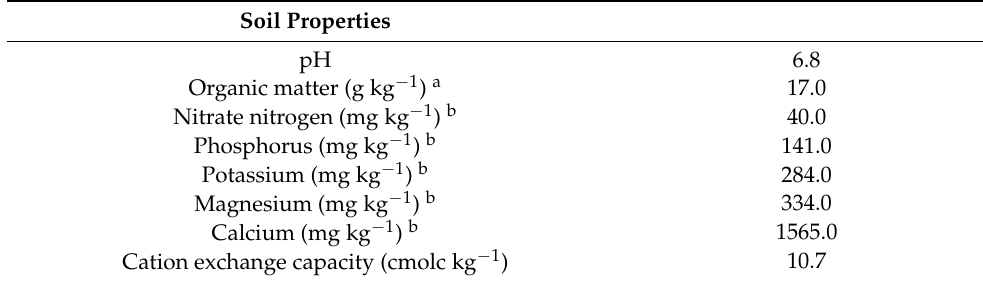
Table 1. Properties of soil used in the study, collected from Badger Farm, The Ohio State University CFAES Wooster Campus, Wooster, OH,